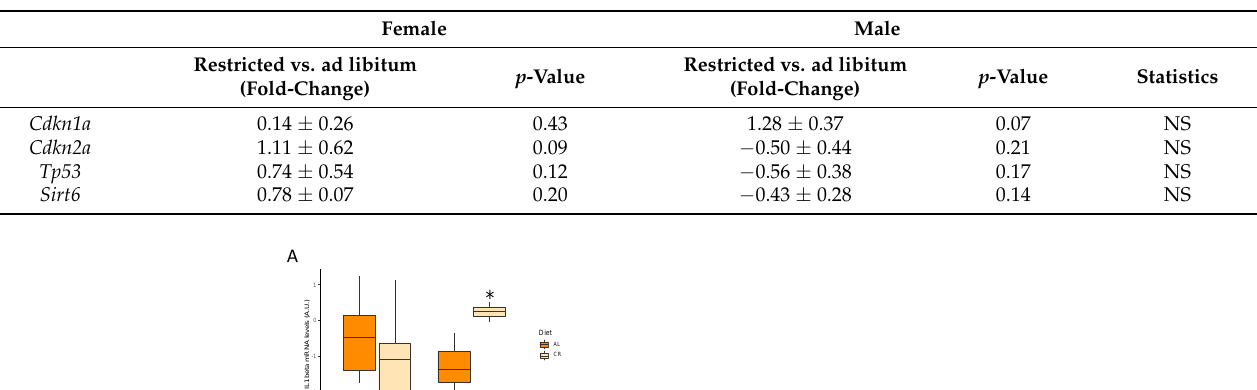
Table 11. mRNA expression levels of senescence markers. Two-way ANOVA was performed to assess for significance. NS: non-significant. Cdkn1a : cyclin-dependent kinase inhibitor 1A; Cdkn2a : cyclin-dependent kinase inhibitor 2A; Tp53 : tumor protein p53; Sirt6 : sirtuin 6.